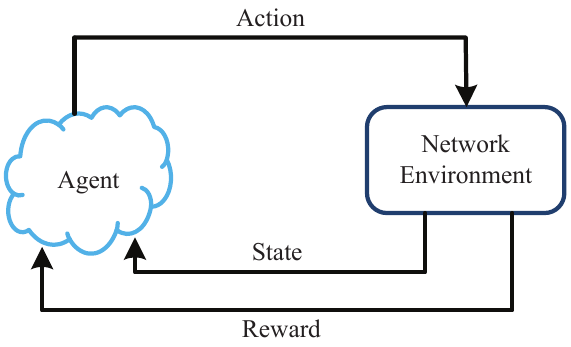
Figure 4. The agent–environment interaction